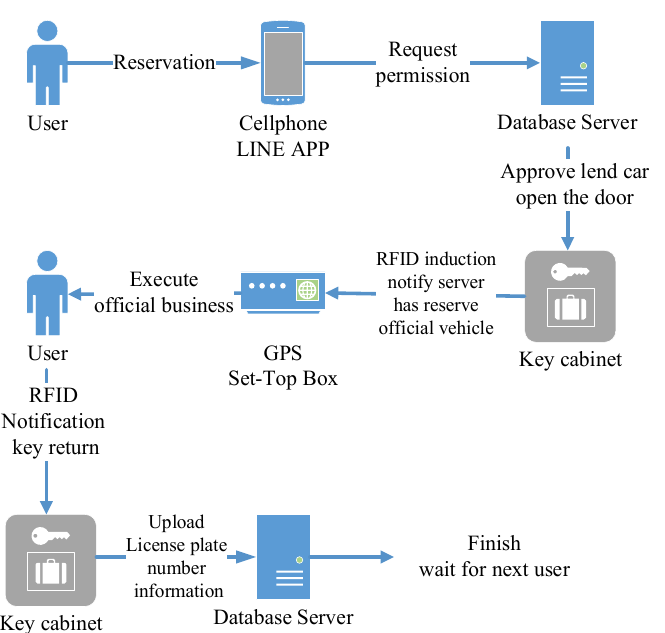
Figure 1. Monitoring management for official vehicles system structure diagram.